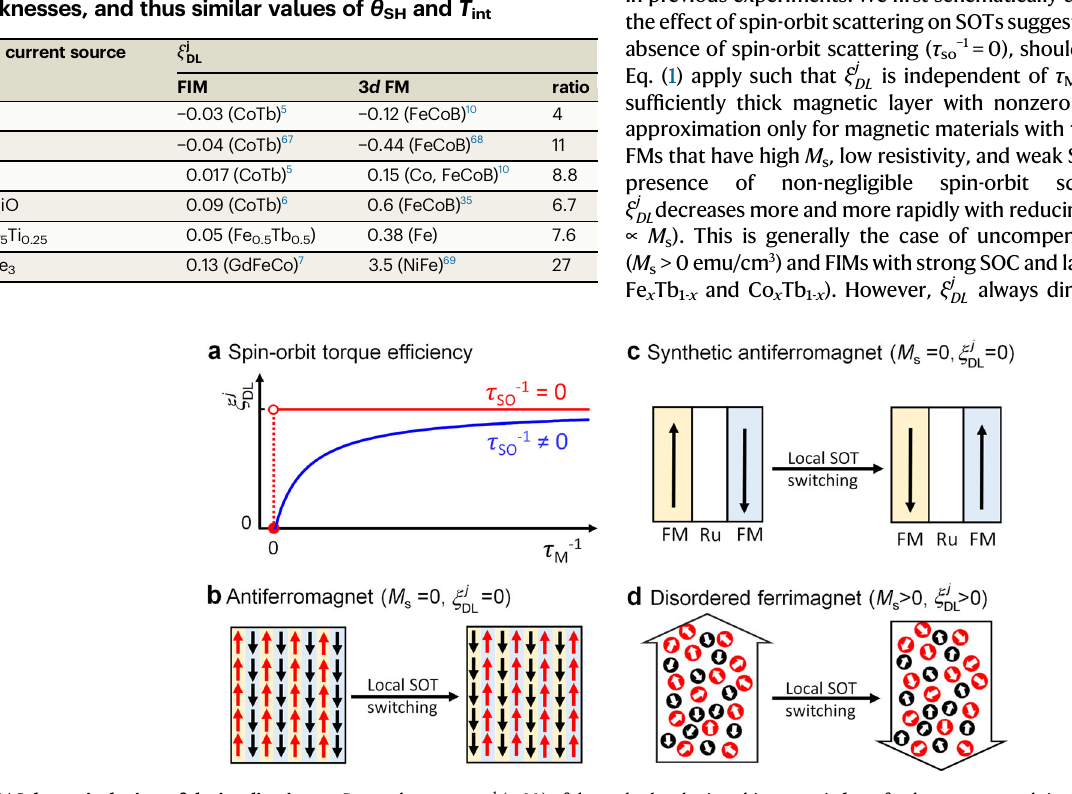
Fig.4|Schematicdepictsoftheimplications.a Dependenceon τ M − 1 ( ∝ M s )ofthe ef fi ciency of the damping-like spin-orbit torque ( ξ j DL ) exerted by a given spin cur- rent on a magnetic layer with zero spin-orbit scattering ( τ so − 1 =0, red) and non- negligiblespin-orbitscattering( τ so − 1 ≠